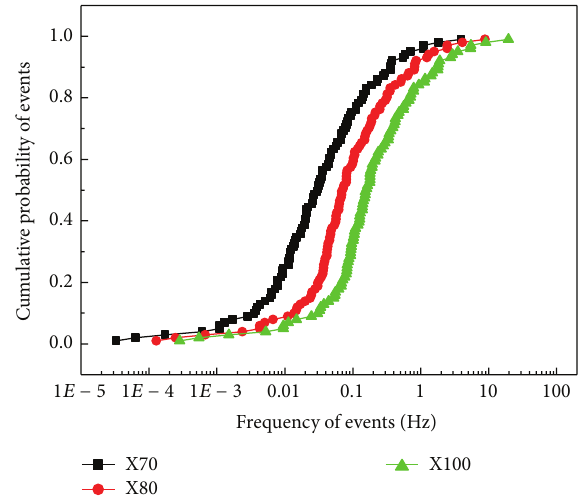
Figure 8: Corrosion charge (𝑞) of passive films formed on X70, X80, and X100 pipeline steels.